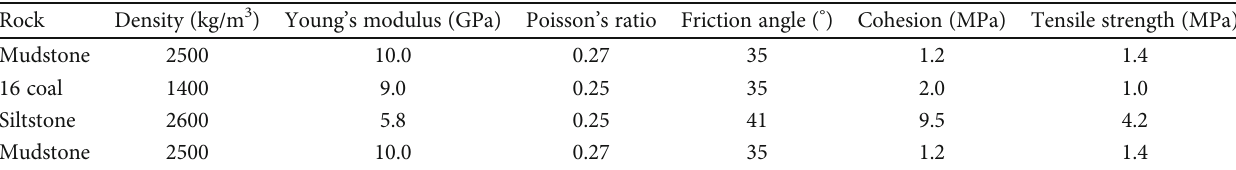
Figure 9: FRACOD models used for investigating the e ff ect of the collapse column in the Luotuoshan mine. The collapse column has no fi xed boundary but has random and fully saturated cracks. The monitoring lines Lv1 ~ 4 are vertical and are located between the collapse column and the working face of the roadway, and monitoring lines Lh1 ~ 4 are horizontal and are beneath the roadway. The inner boundary of the roadway is stress free. The bottom boundary of the model is a displacement boundary, and both sides are roller boundaries. Table 3: Mechanical properties of simulated rocks and